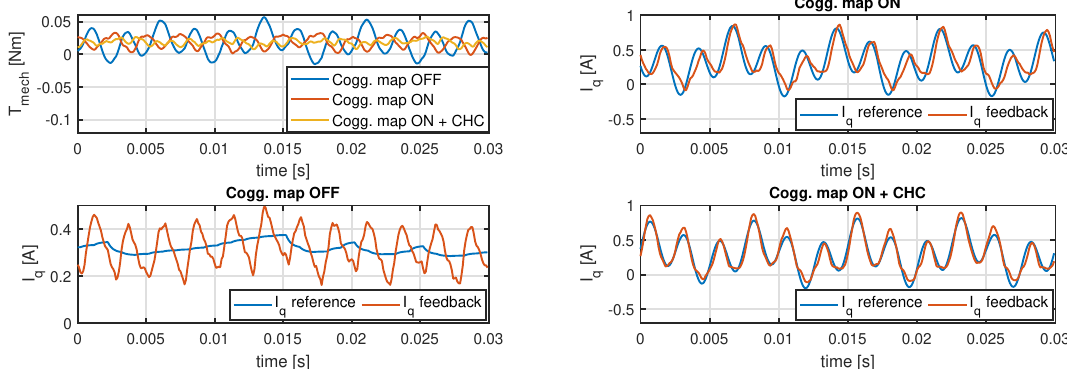
Figure 16. Torque ripple at n r = 1000 rpm and f e = 66.7